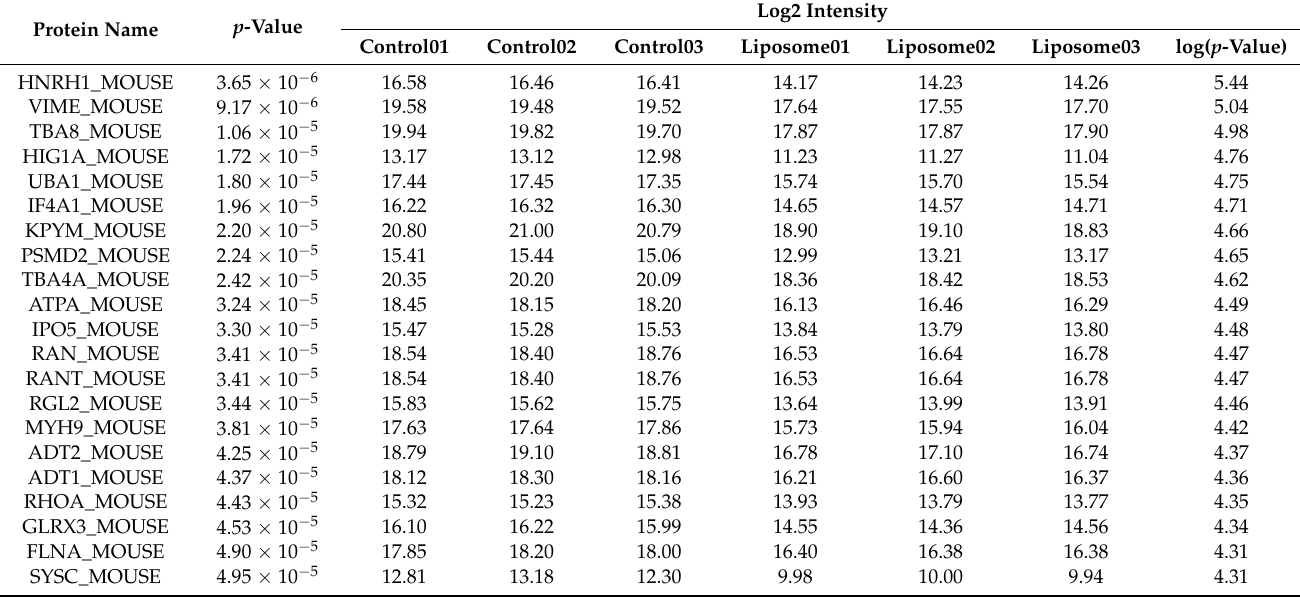
Table A2. Differentially expressed proteins